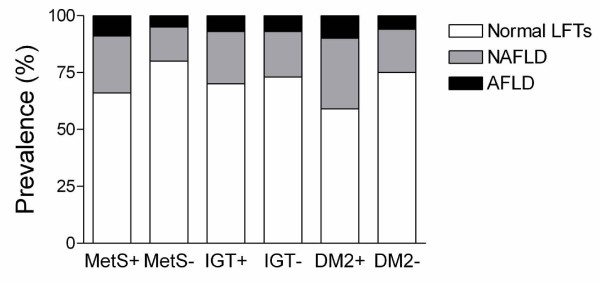
The prevalences of NAFLD and AFLD in subjects with (MetS+) and without (MetS-) the metabolic syndrome, impaired glucose tolerance (IGT), and type 2 diabetes (T2D). Please see text for significances.